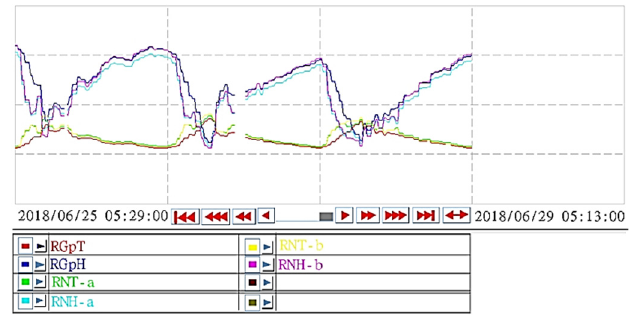
Figure 5. Structure of the cloud management monitoring system.